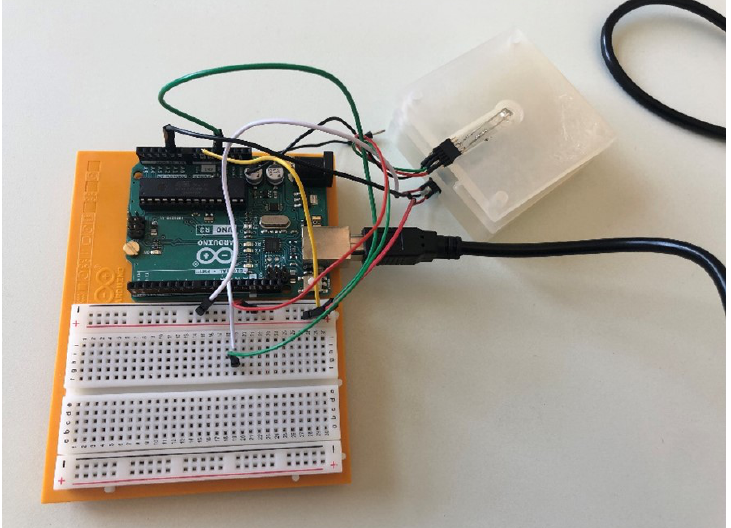
Figure 3. Minilysis concept validation prototype to measure the hemoglobin in the specimen, where the mechanical components were manufactured with 3D printer and the electronic components were connected on a microcontroller Arduino Uno, powered through a universal switching power supply converting 230 V AC to 7.5 V DC, which was then lowered to 5 V by the voltage regulator inside the Arduino Uno.